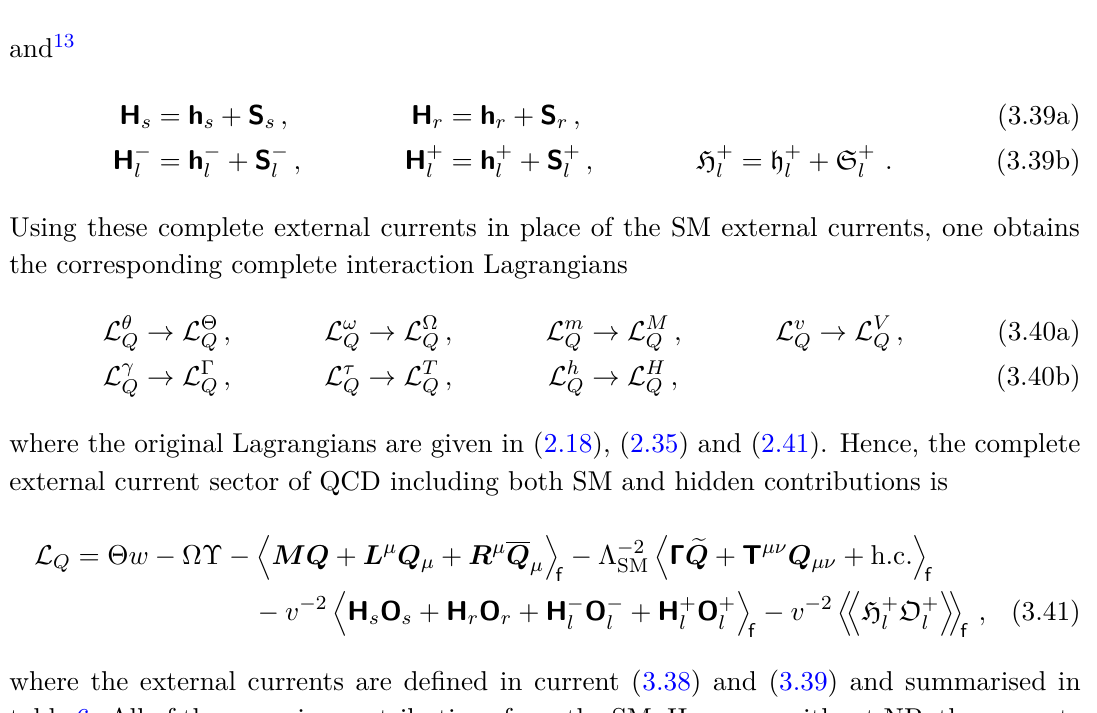
table 6. All of them receive contributions from the SM. However, without NP, the currents Θ , Ω , M , H , H , and H + are constant. The SM contributions to the currents L µ , R µ and x l T µν depend on the photon field, and L µ additionally contains the weak leptonic charged current, cf. (2.27) and